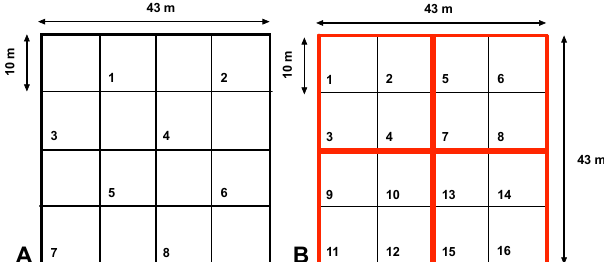
Figure 2. Soil sampling scheme according to Walthert et al. (2002) at the Long-Term Forest Ecosystem (LWF) Research Program, (a) eight individual samples taken in a chessboard pattern, (b) 16 samples that are combined to mixed samples in each plot quadrant, as indicated by the red boxes (1–4, 5–8,